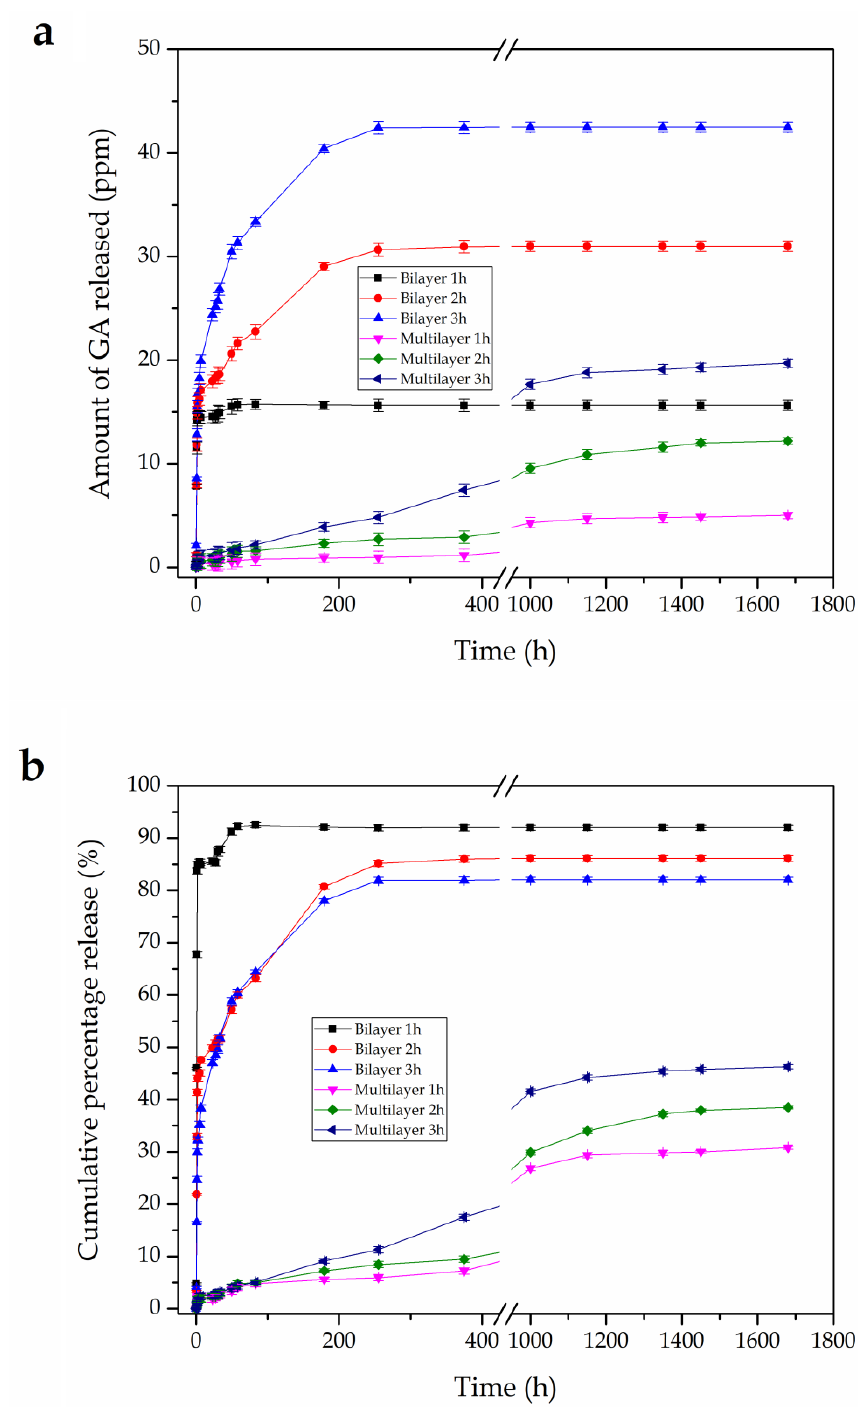
Figure 5. Gallic acid (GA) release from the GA-containing polylactide (PLA) films as a function to the immersion time in saline medium: ( a ) Total amount released; and ( b ) cumulative release.